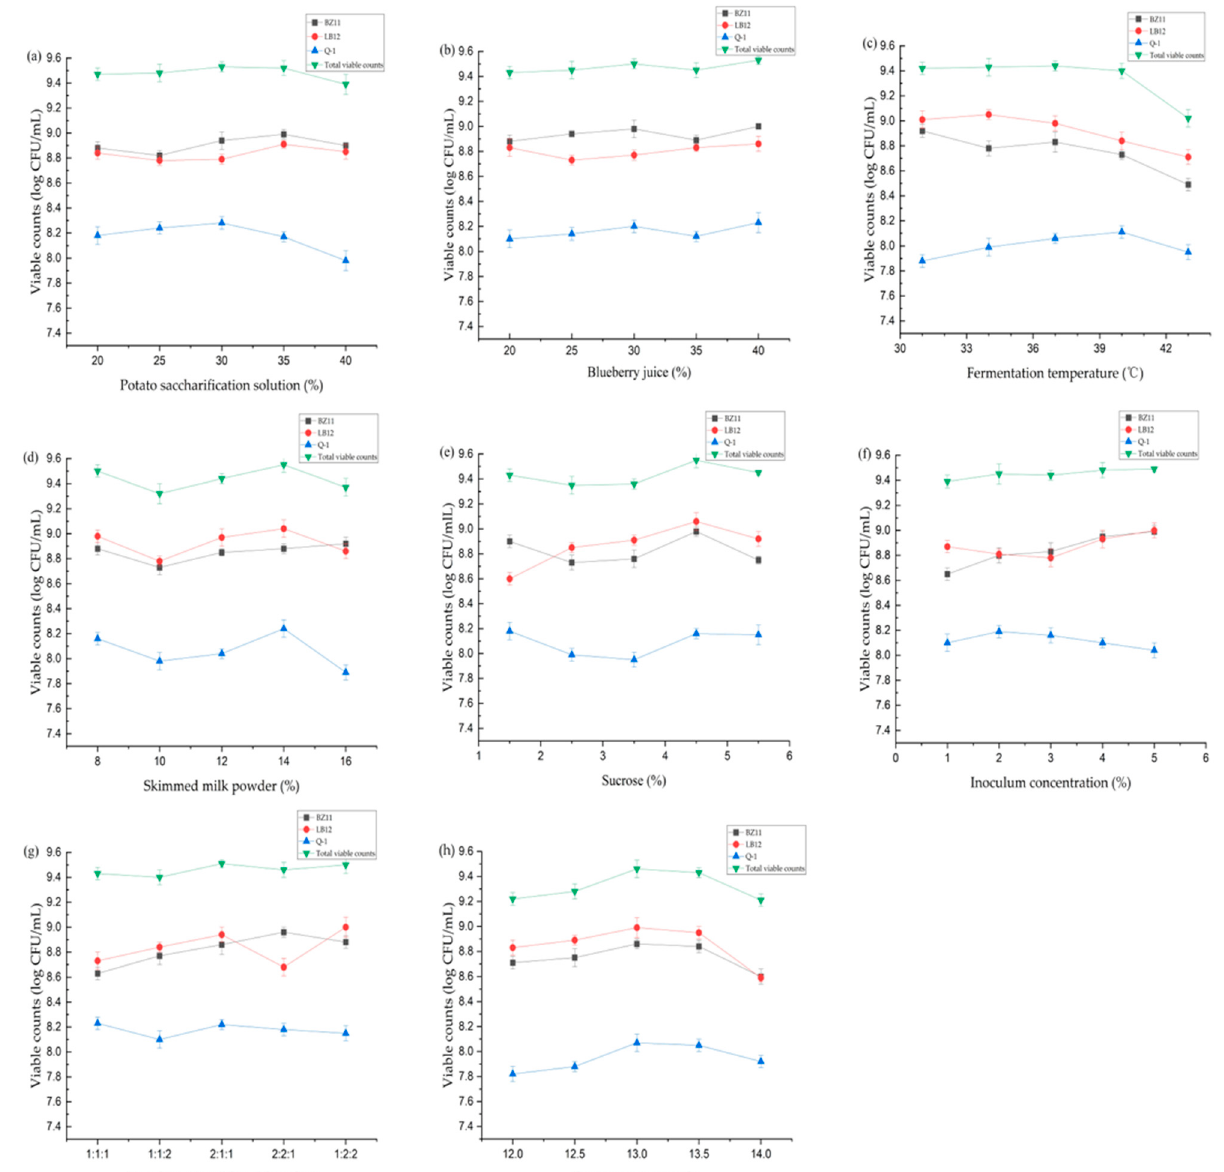
Figure 2. Effect of potato saccharification solution ( a ), blueberry juice ( b ), fermentation temperature ( c ), skimmed milk powder ( d ), sucrose ( e ), inoculum concentration ( f ), inoculum ratio ( g ), and fermentation time ( h ) on the BZ11, LB12, Q-1, and total viable counts of potato blueberry yogurt.